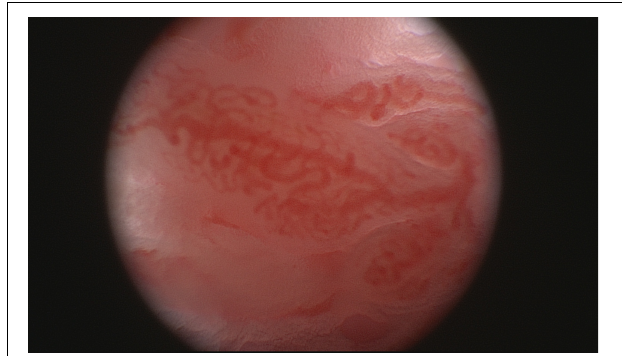
FIGURE 2 | Macroscopic aspects of the synovium of a psoriatic arthritis patient, showing a tortuous and bushy vascularization.